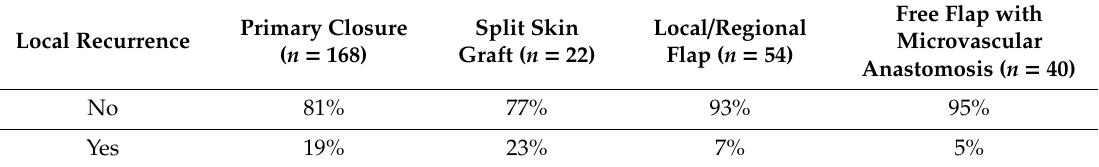
Table 8. Recurrence rate in relation to the di ff erent closure / reconstruction methods. Primary Closure Local Recurrence